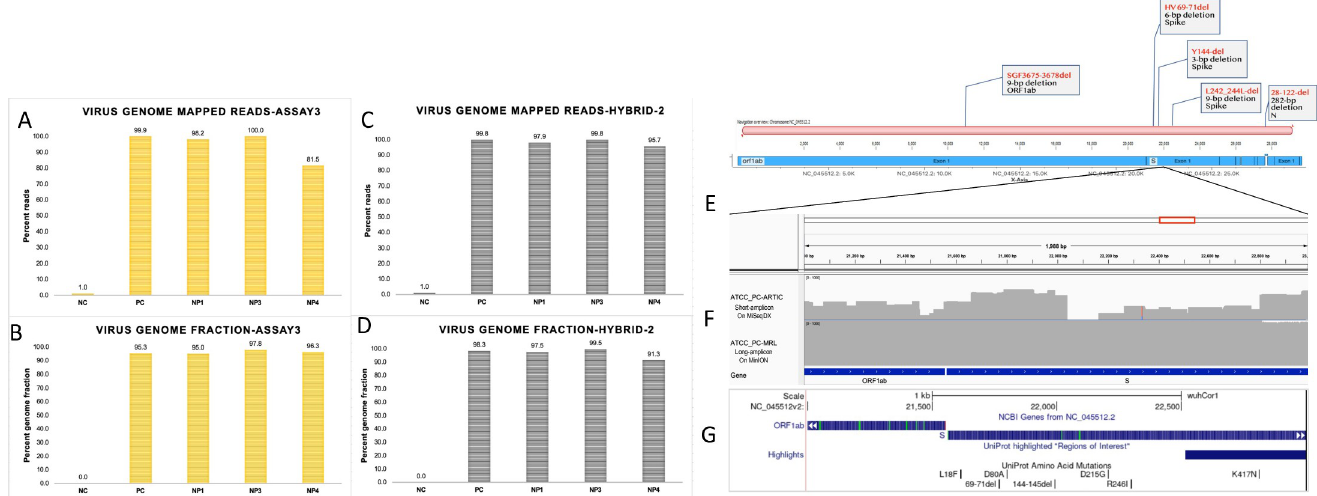
Fig 6. Long-read sequencing provides uniform coverage across deletion-prone region in the virus genome. Panel A shows the percentage of the virus genome mapped sequencing reads (A) and virus genome fraction covered with Nanopore sequencing data (B), in the positive control (VR1986D ATCC SARS-CoV-2 RNA). Panels C-D show reads mapped to the virus genome and covered genomic fraction in combined, ARTIC + Long-read (Hybrid-II) data, respectively. Panel E illustrates a gene sketch on known deletions in 2kb region of the spike gene. Panel F shows sequencing coverage across a deletion-prone region of the spike gene in ATCC positive control RNA in short-amplicon ARTIC and long-amplicon MRL data. Top coverage plot on ATCC_PC_ARTIC shows sequencing coverage in short- amplicon on Illumina MiSeqDx platform, whereas second track underneath show long-read sequencing data on ATCC_PC sample using MRL long-amplicon primers. Panel G shows a UCSC genome browser snapshot across spike gene region that show previously reported deletions in this genomic interval of SARS-CoV-2 genome.